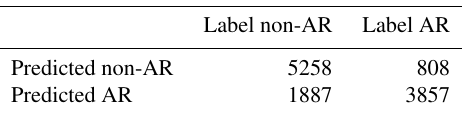
Table B2. Confusion matrix of the method for the testing set – the CAM5.1 data (3-hourly, 100km). It shows the number of correctly recognized (the diagonal) and the number of incorrectly classified events (off-diagonal).